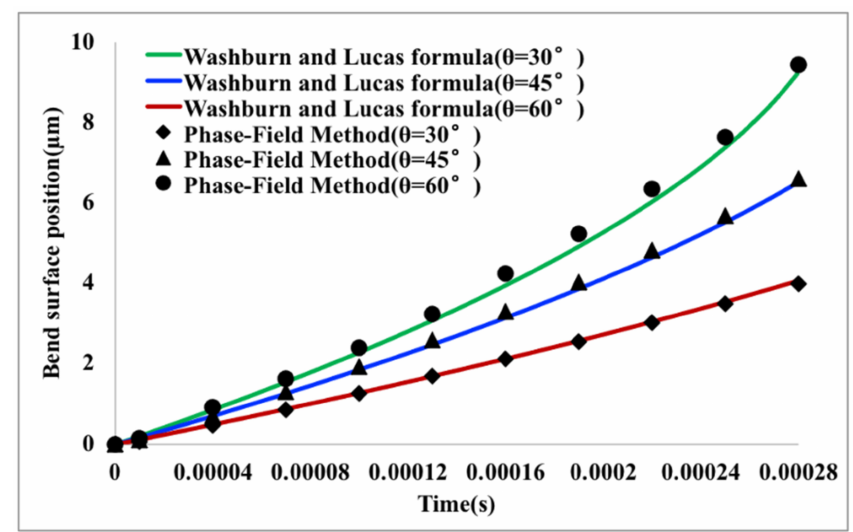
Figure 5. The change of the position of oil-water bend surface with time.